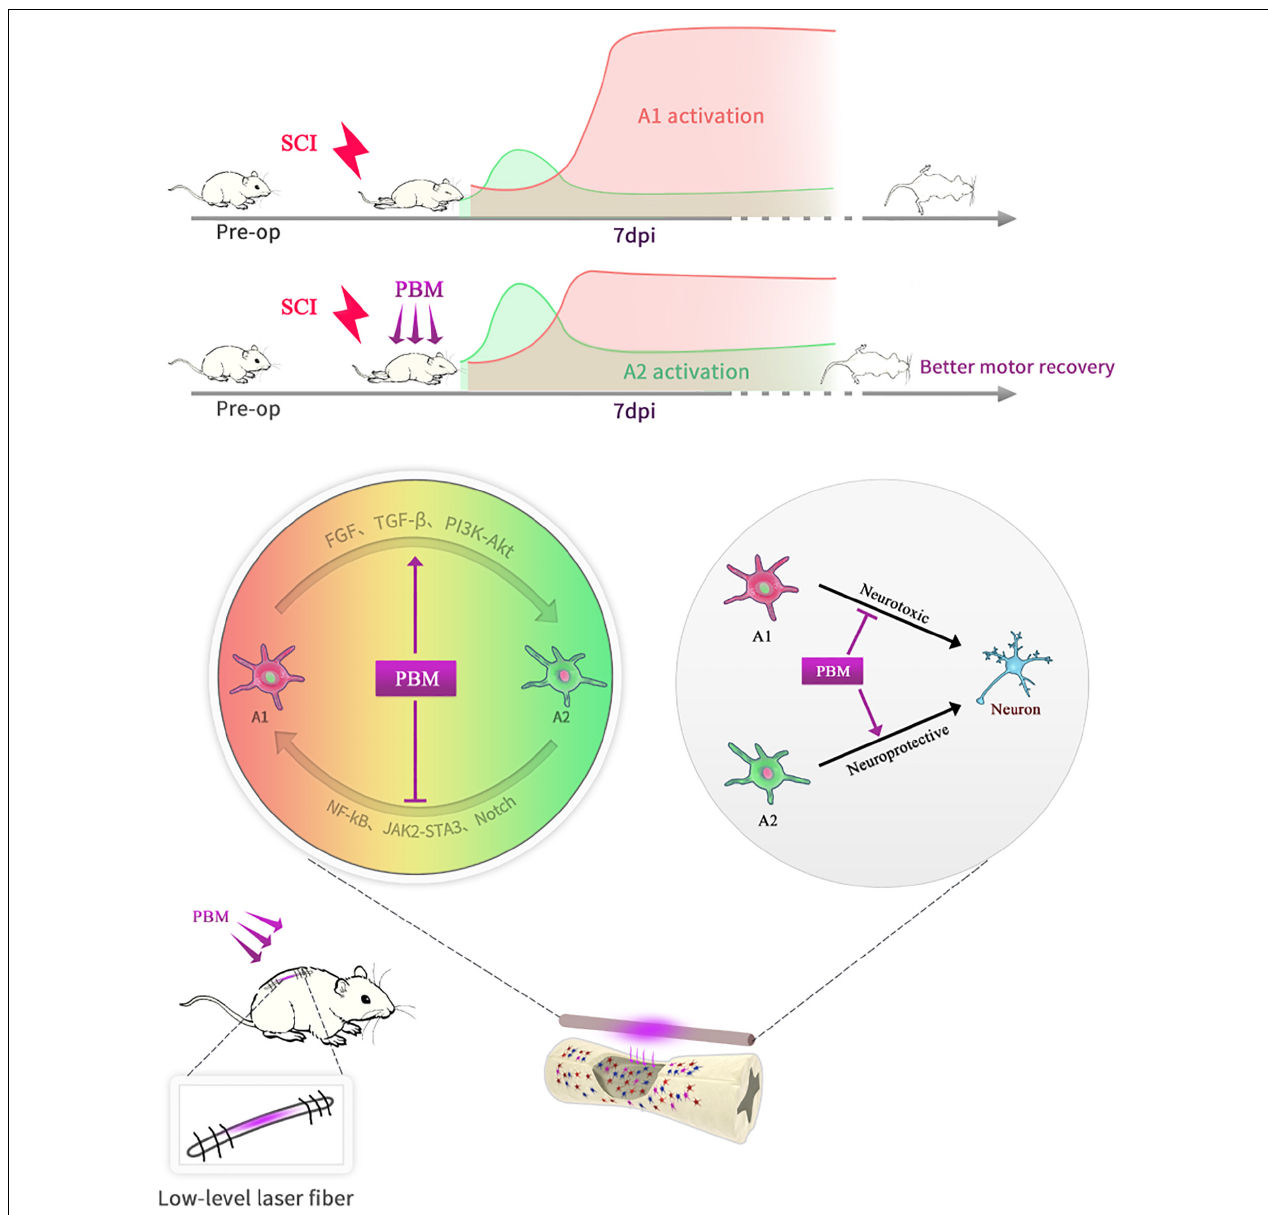
FIGURE 7 | Schematic diagram showing that PBM regulates the transformation of A1/A2 reactive astrocytes. An implantable fiber was embedded in the rat vertebral plate after SCI, and PBM improved motor recovery and promoted tissue repair. At 7 dpi, A1 astrocyte activation was suppressed, and A2 astrocyte activation was promoted after PBM treatment. The mechanism may be related to the ability of PBM to reduce the toxicity of A1 astrocytes to neurons by altering the activation of specific signaling pathways and factors associated with A1/A2 astrocyte activation.